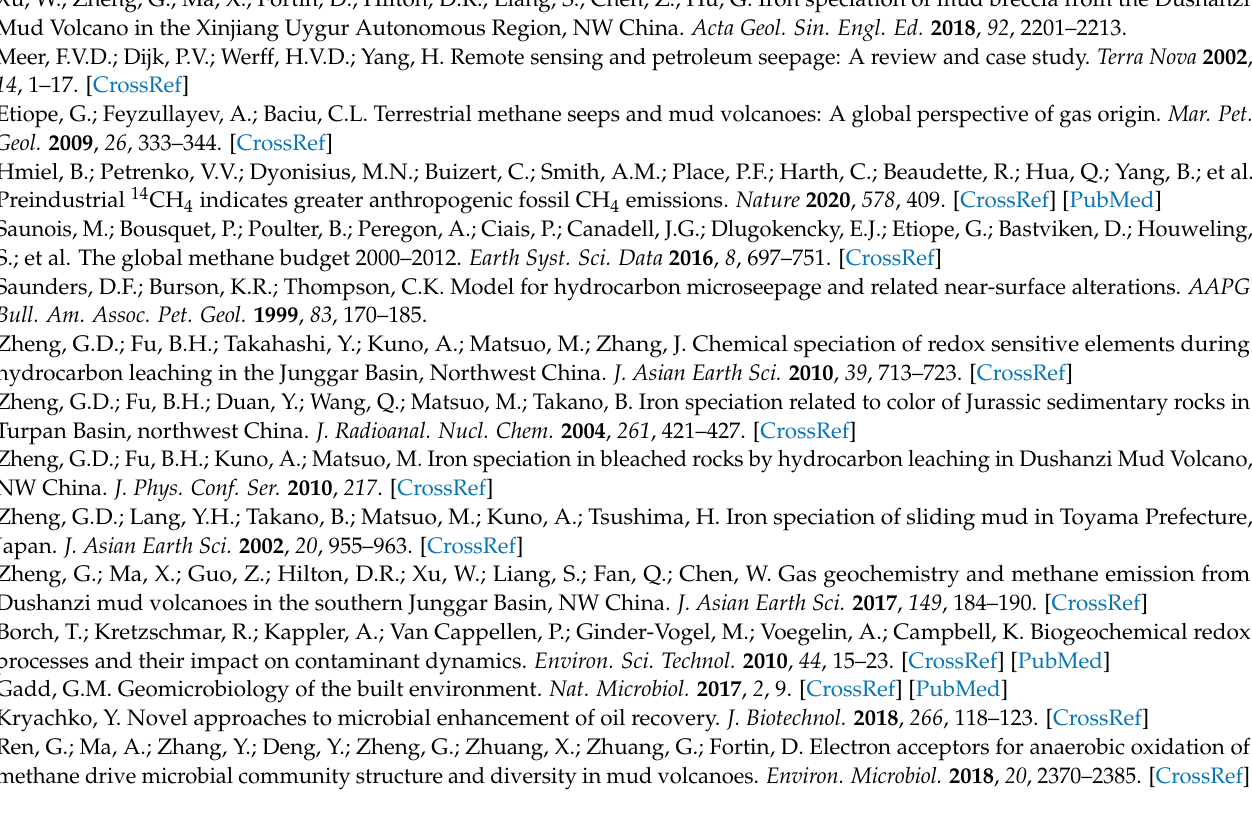
Figure S1: Rarefaction curves of six layers, Figure S2: Melting curves of standards and samples, Figure S3: Standard curves of standards and samples, Figure S4: UPGMA clustering tree based on Weighted Unifrac Distance among six layers, Figure S5: Canonical correspondence analysis (CCA) of prokaryotic communities in six layers, Figure S6: A: Path analysis of microbial community, diversity and richness with iron and other environmental factors. B: The total effect of each factor on iron after standardization, Figure S7: The color of the samples in the serum bottle changed after 50 days of